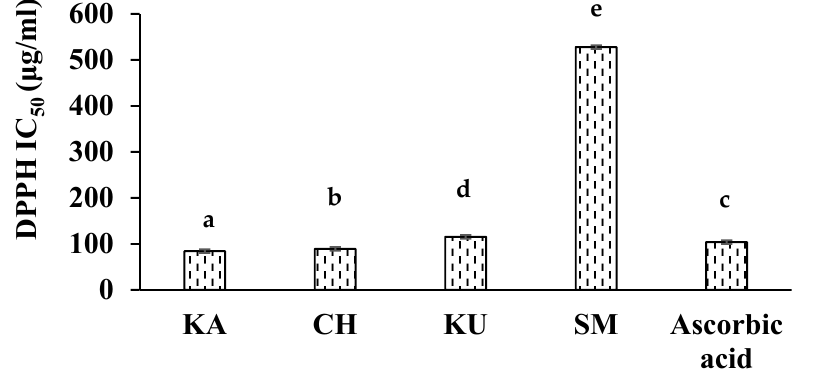
Figure 1. DPPH radical scavenging activity (IC 50 ) of the red rice genotypes. KA—Kattuyanam, CH— Chennangi, KU—Karungkuruvai, SM—Sona masuri (white rice). Different alphabets above the columns indicate significant differences across rice varieties at p ≤ 0.05.